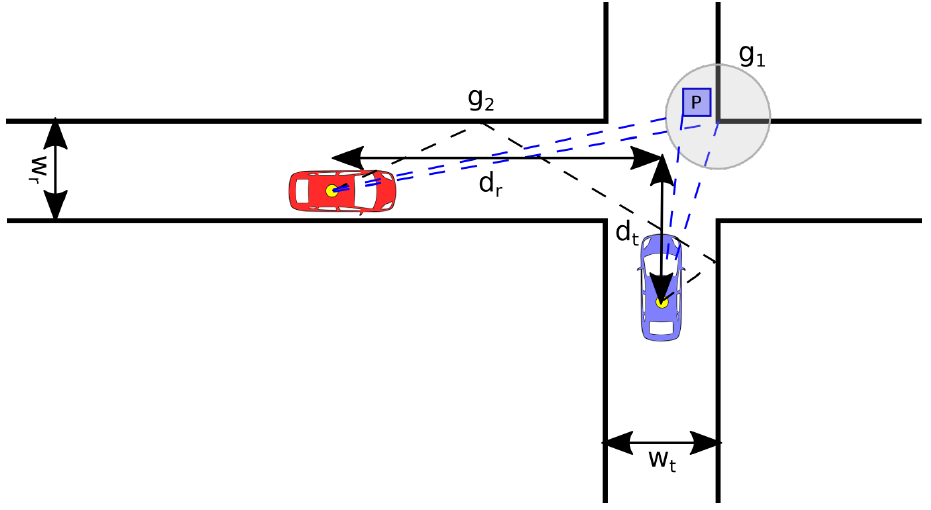
Figure 1. Vehicle-to-vehicle (V2V)-intersection